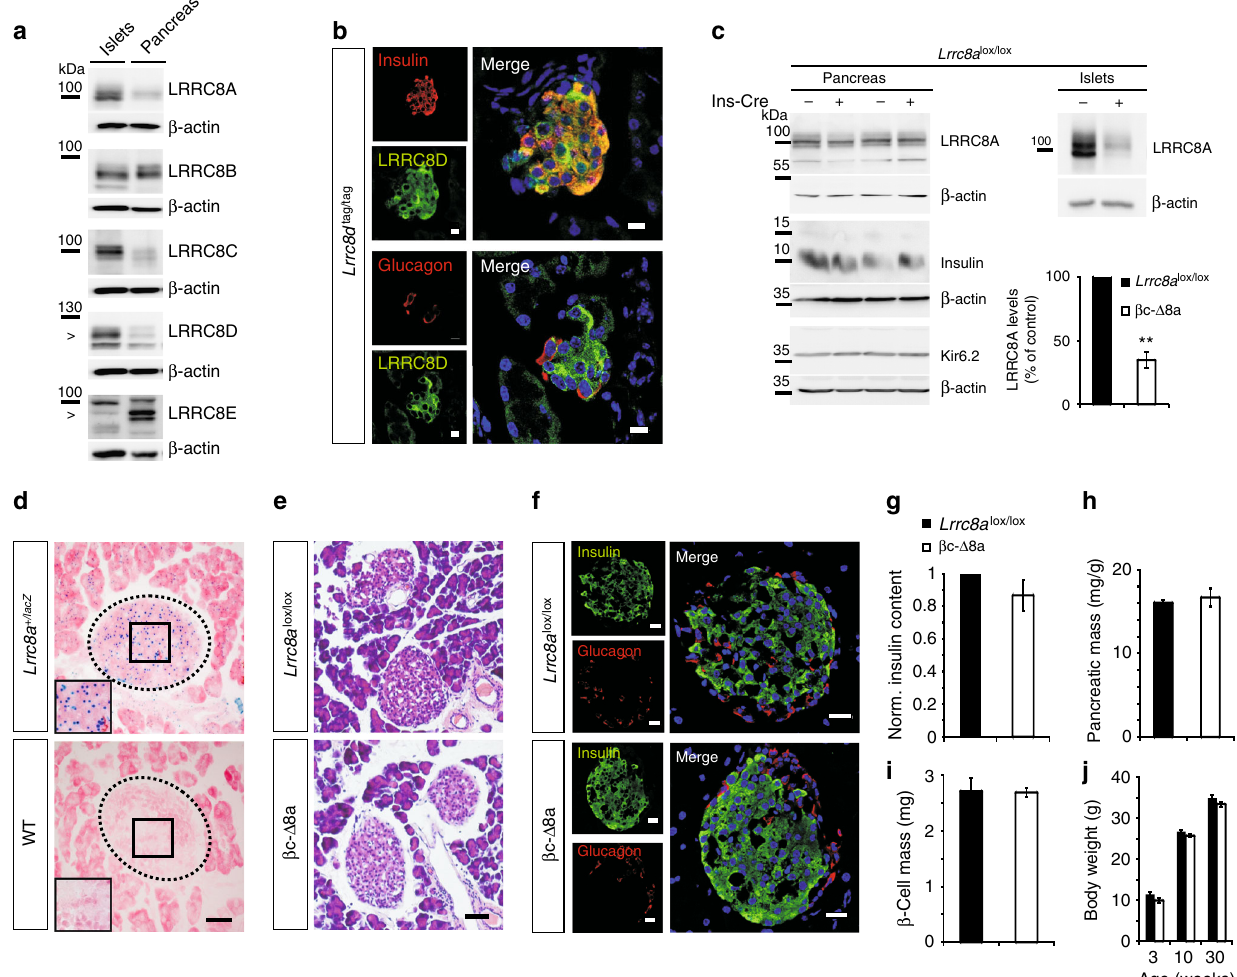
Fig. 1 LRRC8 proteins in the pancreas and normal islet morphology upon β -cell-speci fi c Lrrc8a disruption. a Western blot detection of the fi ve VRAC subunits LRRC8A, -B, -C, -D, and – E in lysates of puri fi ed islets of Langerhans (left lanes) or total pancreas (right) from wild-type mice. β -actin, loading control. Arrowheads highlight speci fi c bands as determined by previous knock-out controls. b Immuno fl uorescent detection (green) of LRRC8D in pancreatic sections from knock-in mice expressing a LRRC8D-tdTomato fusion protein, co-stained (in red) for insulin (above) or glucagon (below). Left panels, individual channels; right panels, overlays, with co-localization yielding yellow. Note that β -cells express much more LRRC8D than the surrounding tissue. c Western blot of lysates from total pancreas or puri fi ed islets probed for LRRC8A, insulin, Kir6.2 (K ATP channel subunit) from Lrrc8a lox/lox mice lacking Cre expression ( − ) or expressing Cre speci fi cally in β -cells ( + ). β -actin, loading control. Right bottom, quanti fi cation of LRRC8A expression in pancreatic islets normalized to Lrrc8 lox/lox control. N = 3 independent experiments. Error bars, mean ± SEM. ** P < 0.01 (Student ’ s t -test). d Lrrc8a promoter-driven β -gal expression (X-gal staining, blue dots) in islets. Dotted lines highlight islets of Langerhans, insets higher magni fi cation of boxed area. Cells co-stained with eosin Y (pink). e Hematoxylin/eosin (H&E) stained formalin- fi xed pancreatic sections of control ( Lrrc8a lox/lox ) or β c- Δ 8a mice (lacking LRRC8A in β -cells). f Immuno fl uorescent staining of pancreatic islets of Lrrc8a lox/lox and β c- Δ 8a animals for insulin (green) and glucagon (red), respectively. g Insulin levels of whole pancreas lysates normalized to control ( Lrrc8a lox/lox ). h Pancreatic mass of Lrrc8a lox/lox and β c- Δ 8a animals determined as ratio of organ to body weight. i β -cell mass as de fi ned as ratio of insulin-positive cell area to complete pancreatic tissue area, multiplied by pancreatic weight. j Body weight of Lrrc8a lox/lox (black bars) and β c- Δ 8a animals (white bars) at 3, 10 and 30 weeks of age. g – j Mean values ± SEM are shown. Differences between genotypes are not signi fi cant in unpaired t -test: g p = 0.185, n = 7; h p = 0.609, n = 3; i p = 0.968, n = 6. j p = 0.086 at 3 weeks, p = 0.05 at 10 weeks, and p = 0.214 at 30 weeks, n = 16 ( Lrrc8a lox/lox ), n = 11 ( β c- Δ 8a). Scale bars in b : 10 µ m, in d – f : 50 µ m